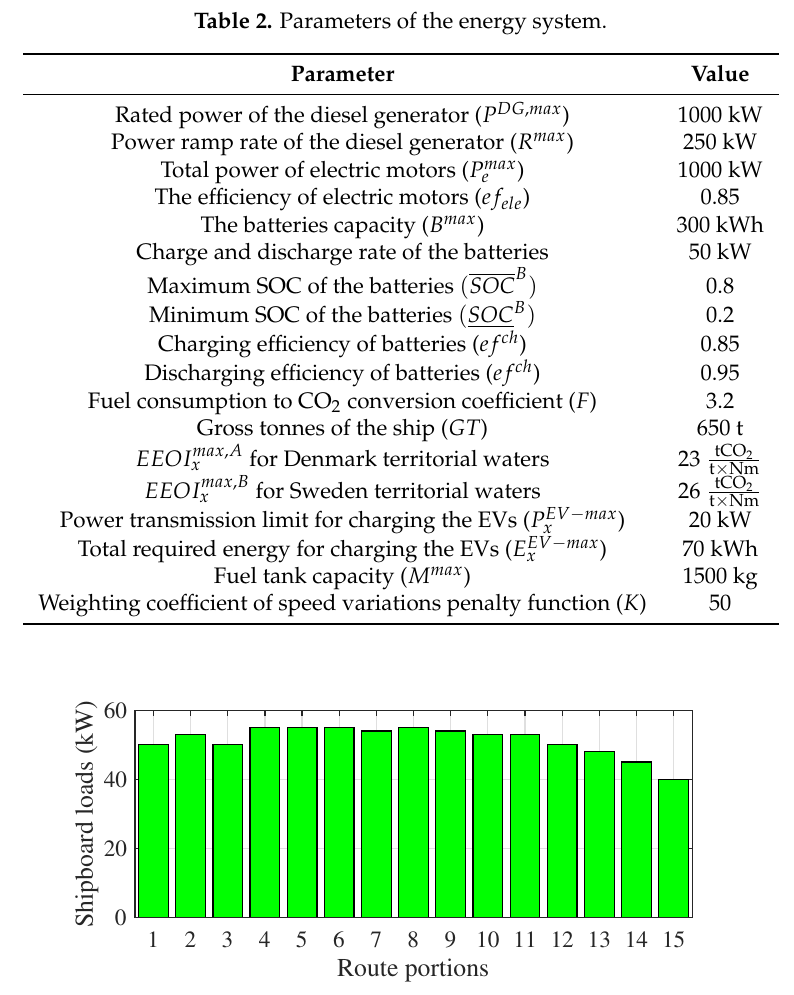
Figure 5. Shipboard load at different route